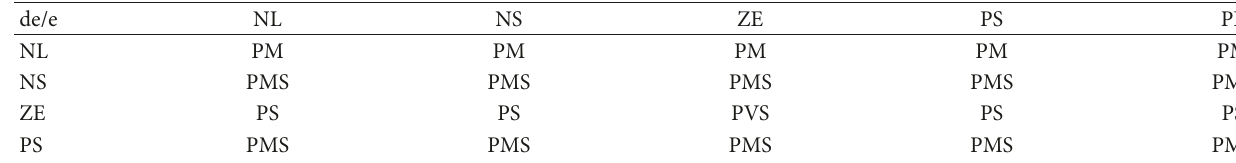
Table 4: Fuzzy rule for 𝑘 𝑖 .